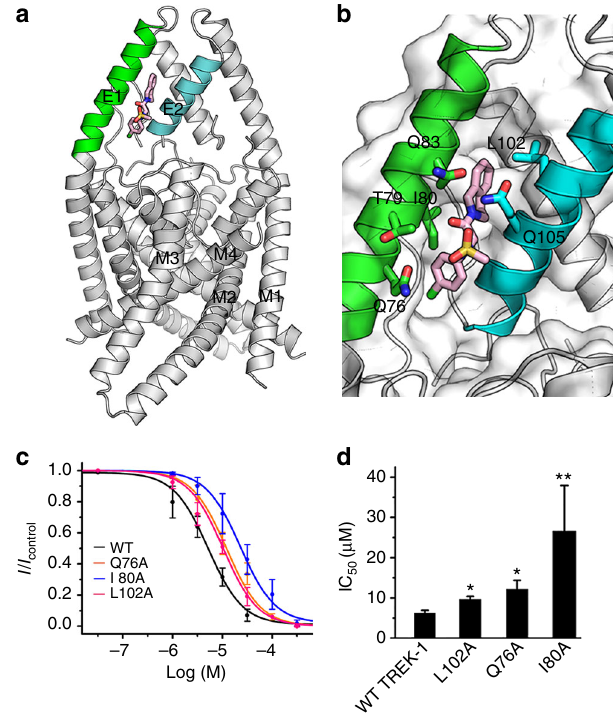
Fig. 2 Binding mode of TKDC to TREK-1. a Binding site of TKDC in the extracellular cap of the TREK-1 channel. b Detailed view of the interactions between TKDC and the TREK-1 channel. TKDC and the residues involved in binding are shown as sticks. The protein is shown in a cartoon and surface depiction. c Dose-dependent inhibition of TKDC on the WT and mutant TREK-1 channels. d Histograms summarizing the half-inhibitory concentrations for WT ( n = 7), L102A ( n = 10), Q76A ( n = 6) and I80A ( n = 3) mutant TREK-1 channels. IC 50 values were obtained via dose – response fi tting. The Kruskal – Wallis test was used for statistical analysis; * indicates P < 0.05, ** indicates P < 0.01. The data are shown as the mean ±